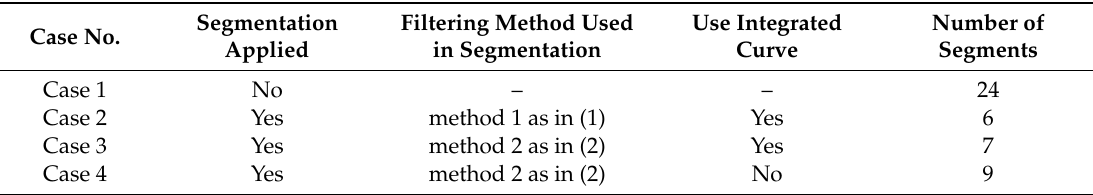
Table 1. Experimental parameters for case 1 to